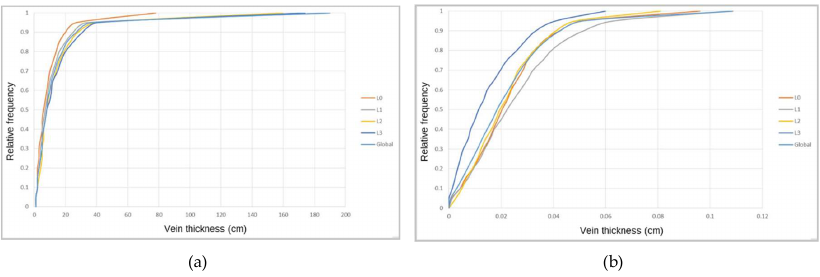
Figure A3. Cumulative histograms for stope variables: ( a ) Vein thickness, ( b ) vein proportion, and ( c ) wolframite quantity.